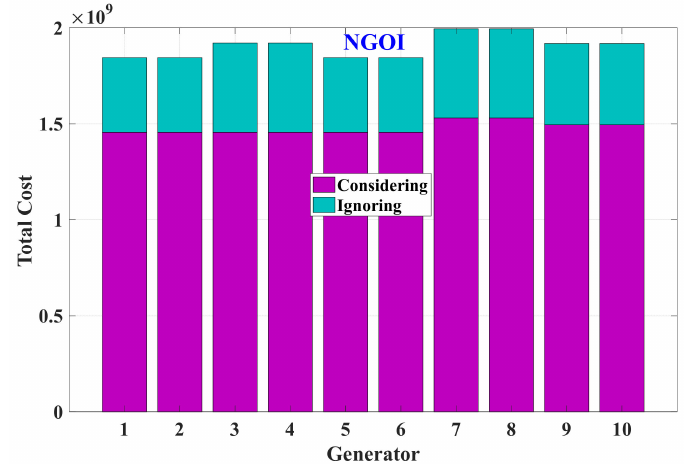
Figure 14. The total cost under the generation unit